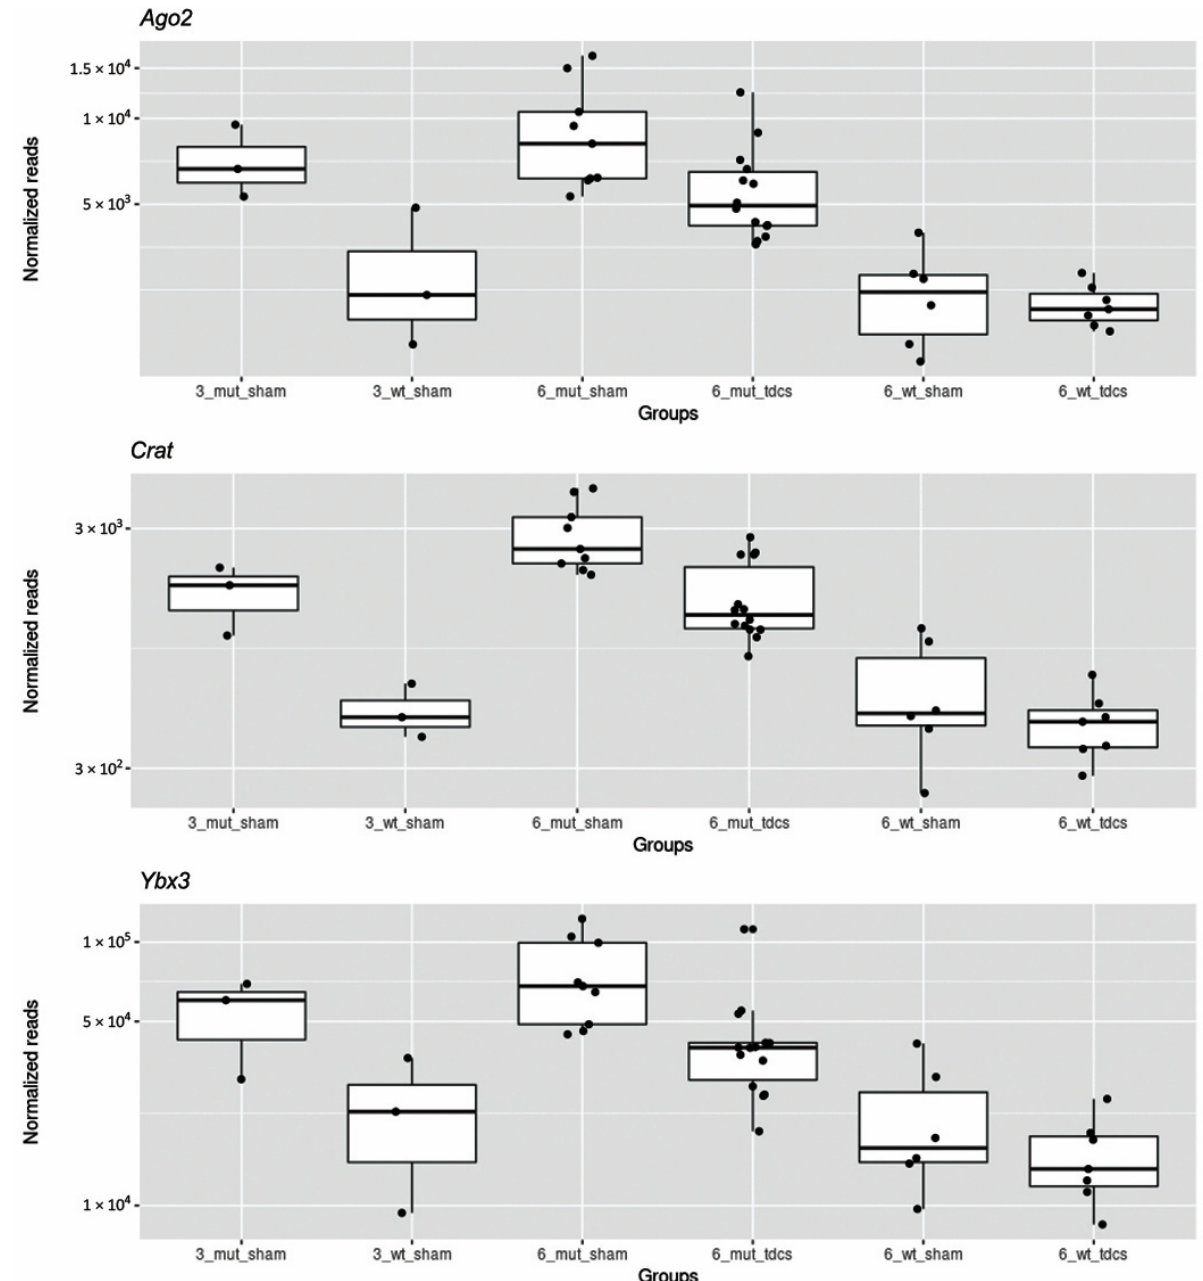
Figure 5. Boxplot of normalized reads for genes modulated by tDCS and deregulated in the 3xTg-AD mouse. Normalized reads were those calculated and used by DESeq2 software. A log scale is used for the Y axis. It is of note that 6 mo. 3xTg-AD mice undergoing tDCS stimulation (6_mut_tdcs) have expression levels that are in between that of 6 mo. 3xtg-AD mice undergoing sham stimulation (6_mut_sham) and 6 mo. WT mice undergoing sham stimulation (6_wt_sham).